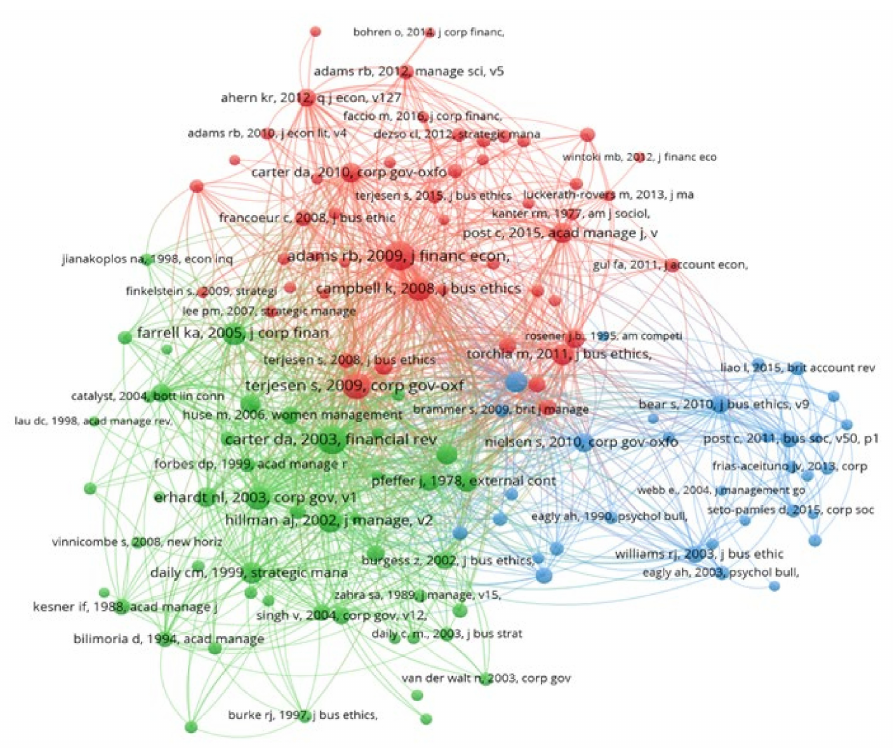
Figure 6. The bibliometric map of cited